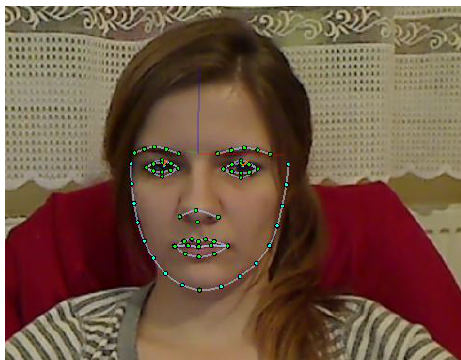
Figure 2. An example of facial tracker using Blink8